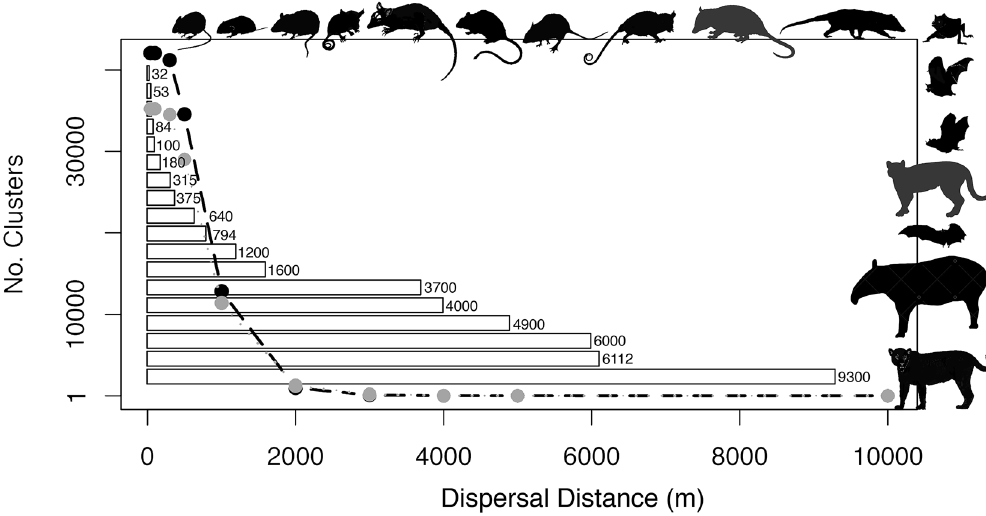
Figure 6. Comparison of number of clusters by distance for 2000 (gray line) and 2019 (black line). Superimposed bars represent documented field travel distances (m) for selected Atlantic Forest species. From top from left to right: Oligoryzomys nigripes, Thaptomys nigrita, Akodon montensis, Gracilinunus microtarsus*, Metachirus nudicaudatus, Rhipidomys mastacalis*, Nectomys squamipes, Marmosa paraguayana, Didelphis aurita, Philander frenata, on right margin top to bottom, Desmodus rotundus, Artibeus fimbriatus, Carollia perspicillata, Leopardus pardalis, Artibeus lituratus, Tapirus terrestris, and Panthera onca (see Table 1 for entire details and additional species). *Identifies species not found in Paraguay but which have generic counterparts that might have similar dispersal abilities. Species silhouettes were generated with Photoshop and figures